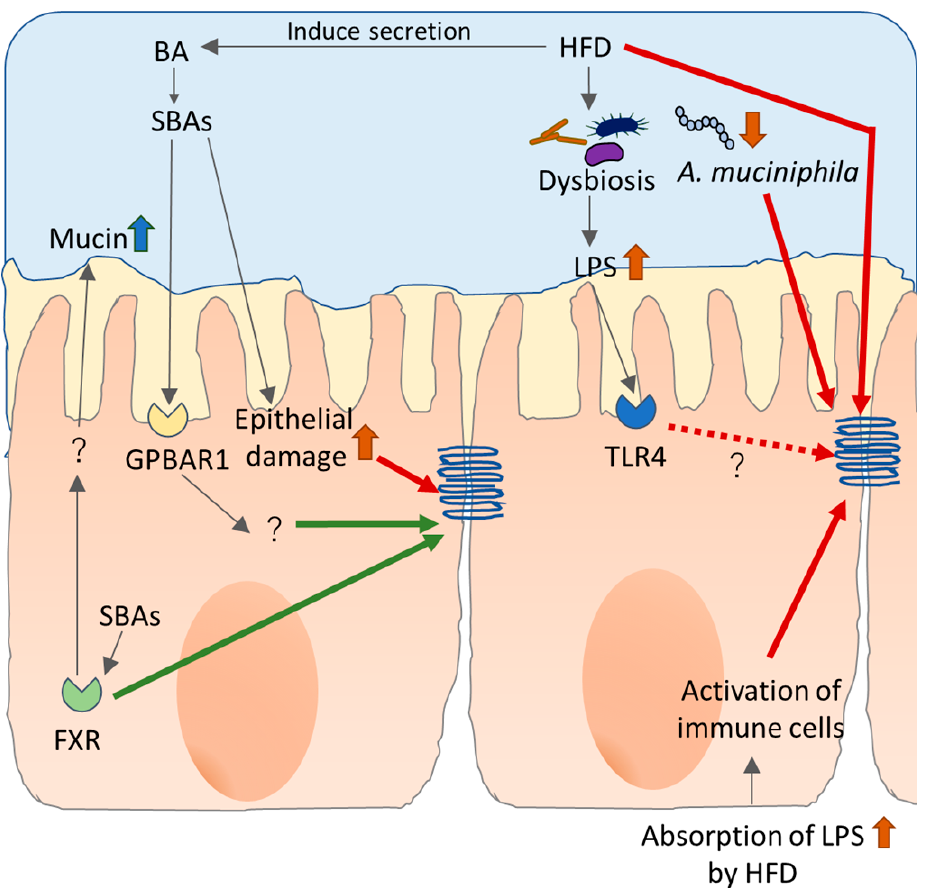
Figure 5. Effects of high-fat diet (HFD) and bile acids (BAs) on tight junction (TJ). Fatty acids impair TJ function directly and open the leak pathway. In addition, HFD affects the pollution of bacteria and exacerbates LPS production. Dysfunction of TJ lets LPS invade into epithelial cells where it becomes the target of immune cells, which provokes further damage to TJ. HFD also induces secretion of BAs which are converted to cytotoxic secondary BAs (SBAs) by bacteria. Nevertheless, SBAs show a protective effect on TJ function via G protein-coupled bile acid receptor (GPBAR1) and farnesoid X receptor